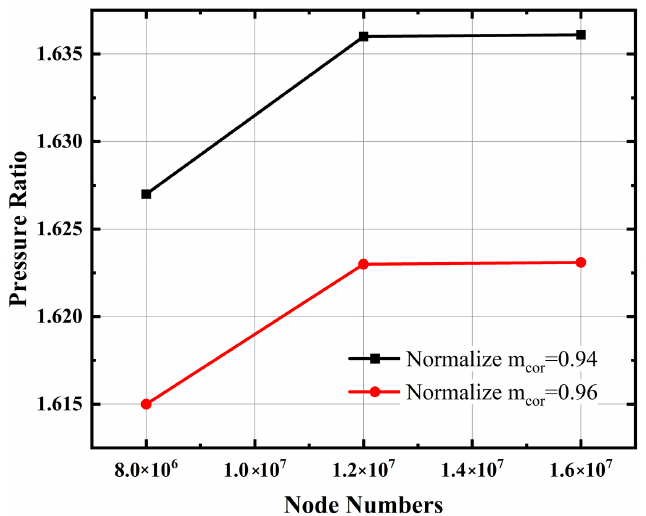
Figure 3. Mesh independence study for NASA Stage 67.